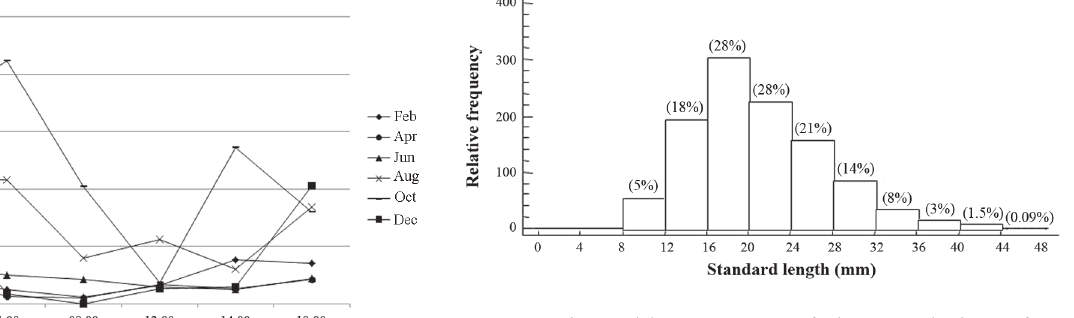
Fig. 6. Bimonthly structure of the population of G. multiradiatus in San Martin. Shows the curves of growth with the von Bertalanffy model for highly seasonal cycles. Upon reaching the asymptotic curve determines the final class of each age